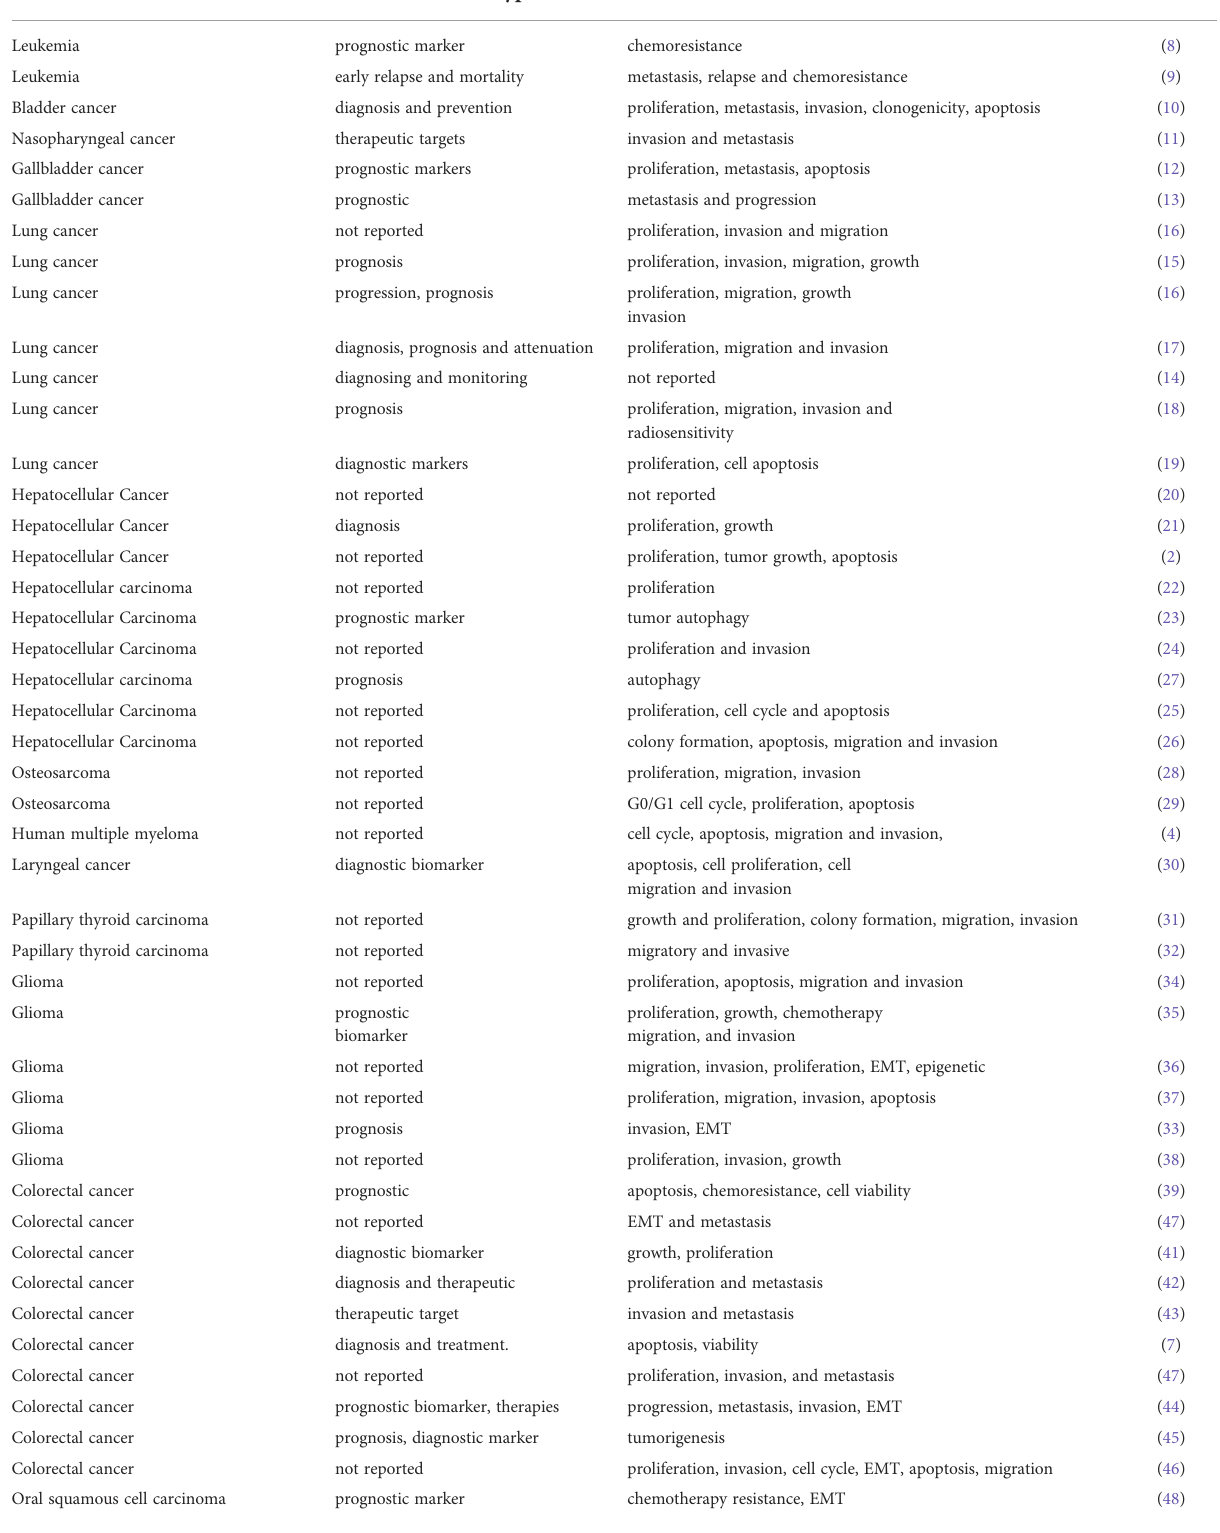
TABLE 2 Biomarkers of LINC00152 in various